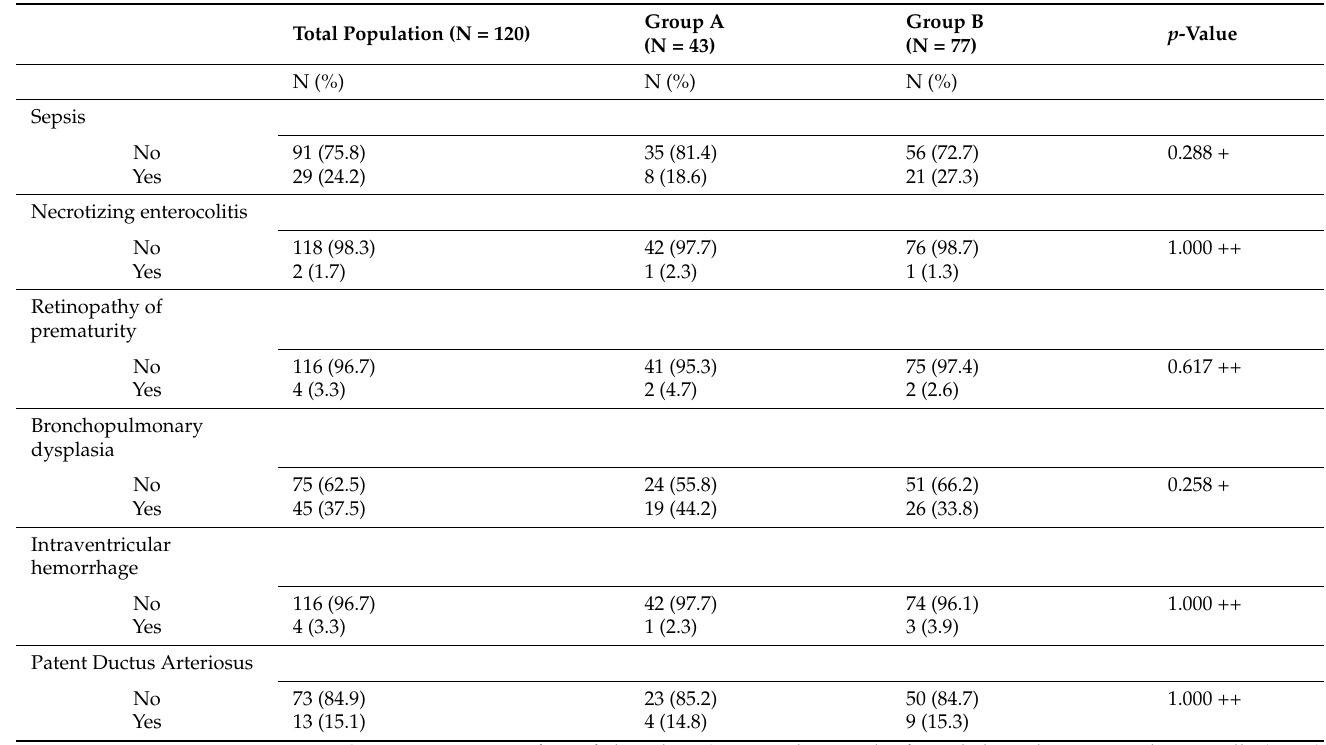
Table 4. Morbidity of the study population during